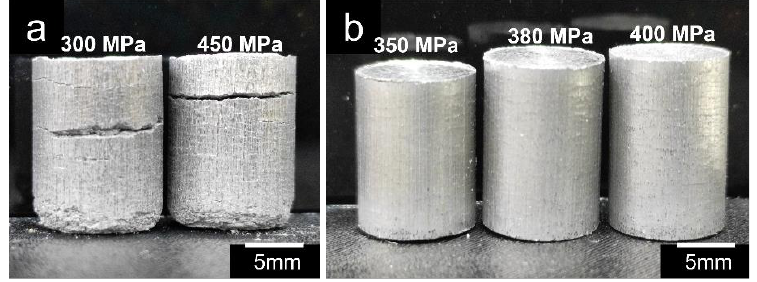
Figure 5. Samples compacted at ( a ) 300 and 450 MPa, and ( b ) at 350, 380, and 400